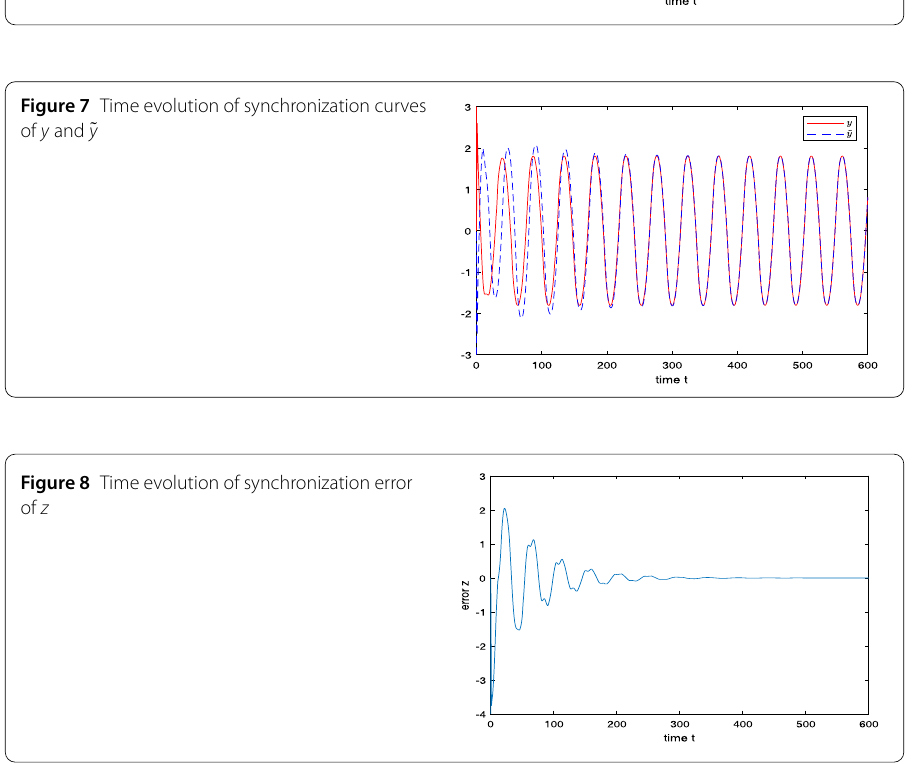
Figure 7 Time evolution of synchronization curves of y and ˜ y